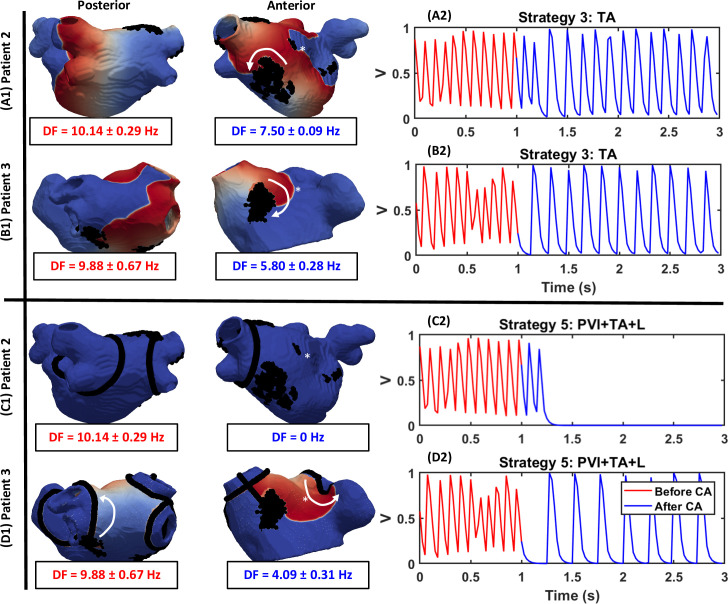
Target area guided ablation with Strategy 5 successfully terminated AF.Voltage maps showing the behaviour of RDs after CA of: (A1-B1) TAs and (C1-D1) TAs plus linear lesions joining them to the PVI lesions and the mitral valve (MV) in Patient 2 and 3, respectively. Panels on the right (A2-D2) show the voltage at the point indicated by * in the respective LA models, before (red) and after (blue) CA. Out of the two strategies, PVI plus TA guided ablation successfully terminated AF in both patients.